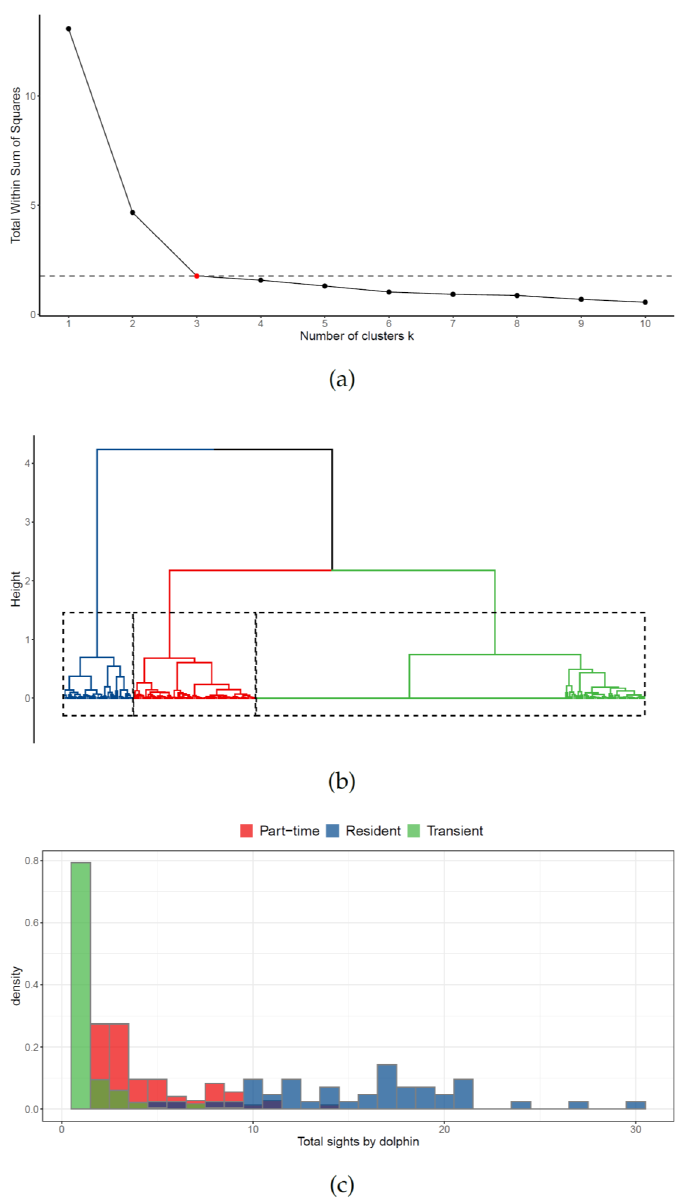
Figure 2. Results of the cluster analysis: ( a ) optimal number of clusters; ( b ) cluster dendrogram; ( c ) distributions of total individual identifications by cluster.